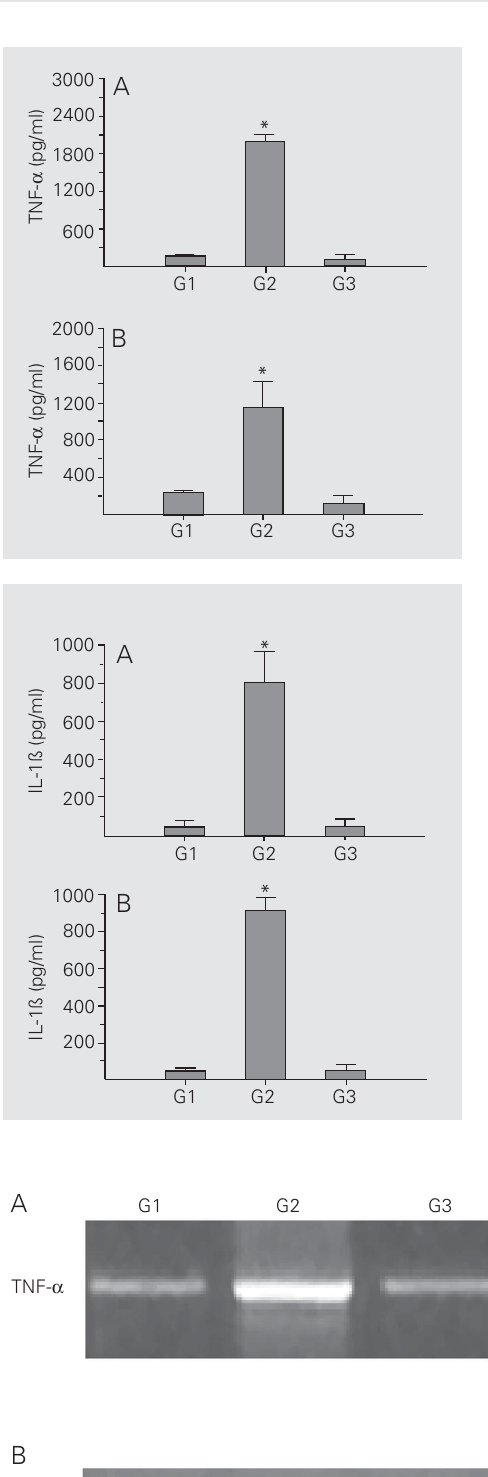
Figure 3. Effect of tidal volumes on TNF- α mRNA expression in lungs of rats subjected to me- chanical ventilation. G1 (V T = 7 ml/kg with normal saline infu- sion; N = 7); G2 (V T = 42 ml/kg with normal saline infusion; N = 7), and G3 (V T = 42 ml/kg with PTX infusion (50 mg/kg); N = 7). Cellular RNA of lung tissue was harvested 180 min after mechan- ical ventilation and subjected to semiquantitative RT-PCR. A , TNF- α ; B , control glyceraldehyde-